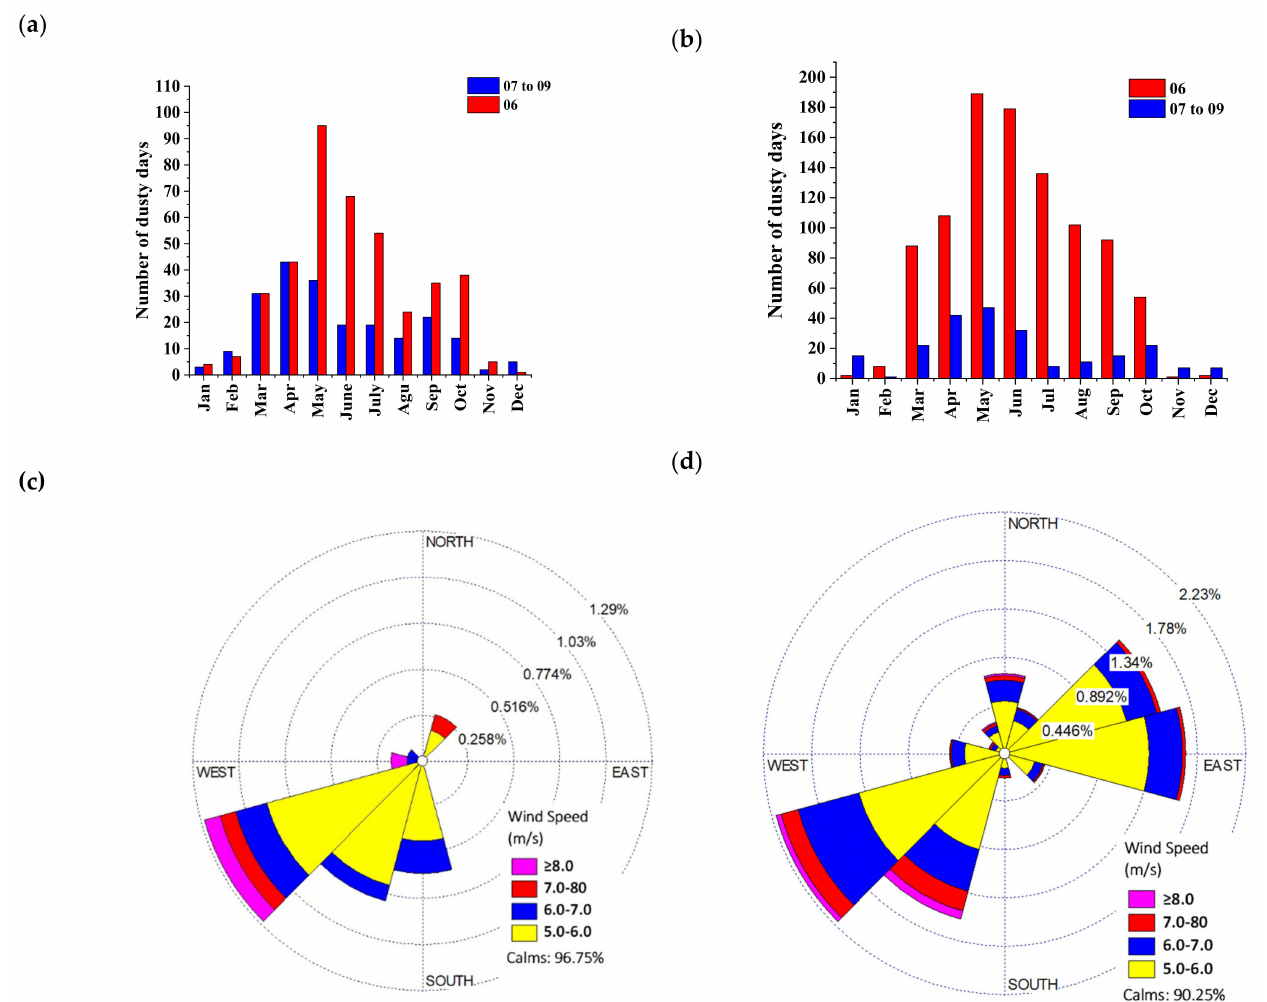
Figure 4. The total number of dusty days per month related to the 06, 07, and 09 weather codes and the wind roses at the weather stations of ( a , c ) Urmia City and ( b , d ) Tabriz City over the 21 years from 2000 to 2020. Here, Calms refer to winds with speeds less than 5 m · s − 1